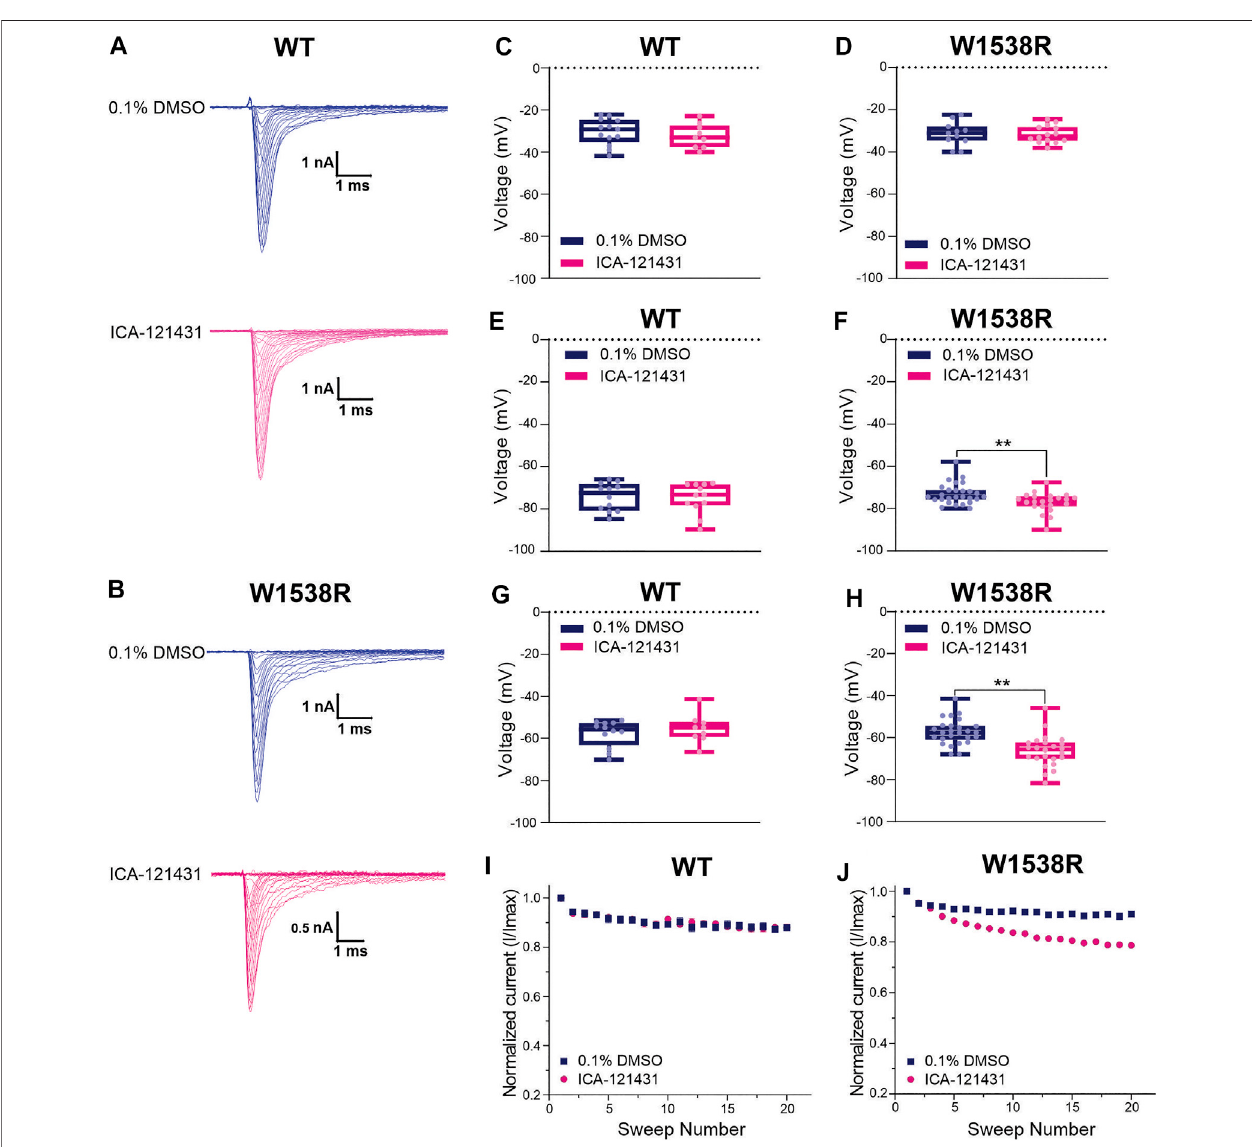
FIGURE 5 | The aryl-sulfonamide Na V 1.3-selective inhibitor ICA-121431 blocks Na V 1.7-W1538R mutant channels. The sodium current traces were produced using the activation protocol from Na V 1.7 (A) WT and (B) W1538R-expressing cells. The half-inactivation voltage (V 1/2 ) of (C,D) Activation, (E,F) Fast-inactivation and (G,H) Slow-inactivation was calculated from the Boltzmann fi ts and averaged for each genotype in response to 0.1 μ M ICA-121431 (pink) or vehicle (0.1% DMSO in extracellularbathsolution;blue).Dataareshownasscatterplotsandboxesatthe25and75thpercentileofthedatawithmedians ± min/max.P* < 0.05,P** < 0.01. The use-dependence of inhibition of (I) WT and the (J) W1538R channels in response to treatment with 0.1 μ M ICA-121431 or vehicle was normalized to the fi rst pulse and averaged across a series of twenty 20 Hz pulses. Data are shown means ± SEM. p * < 0.05, p ** < 0.01.